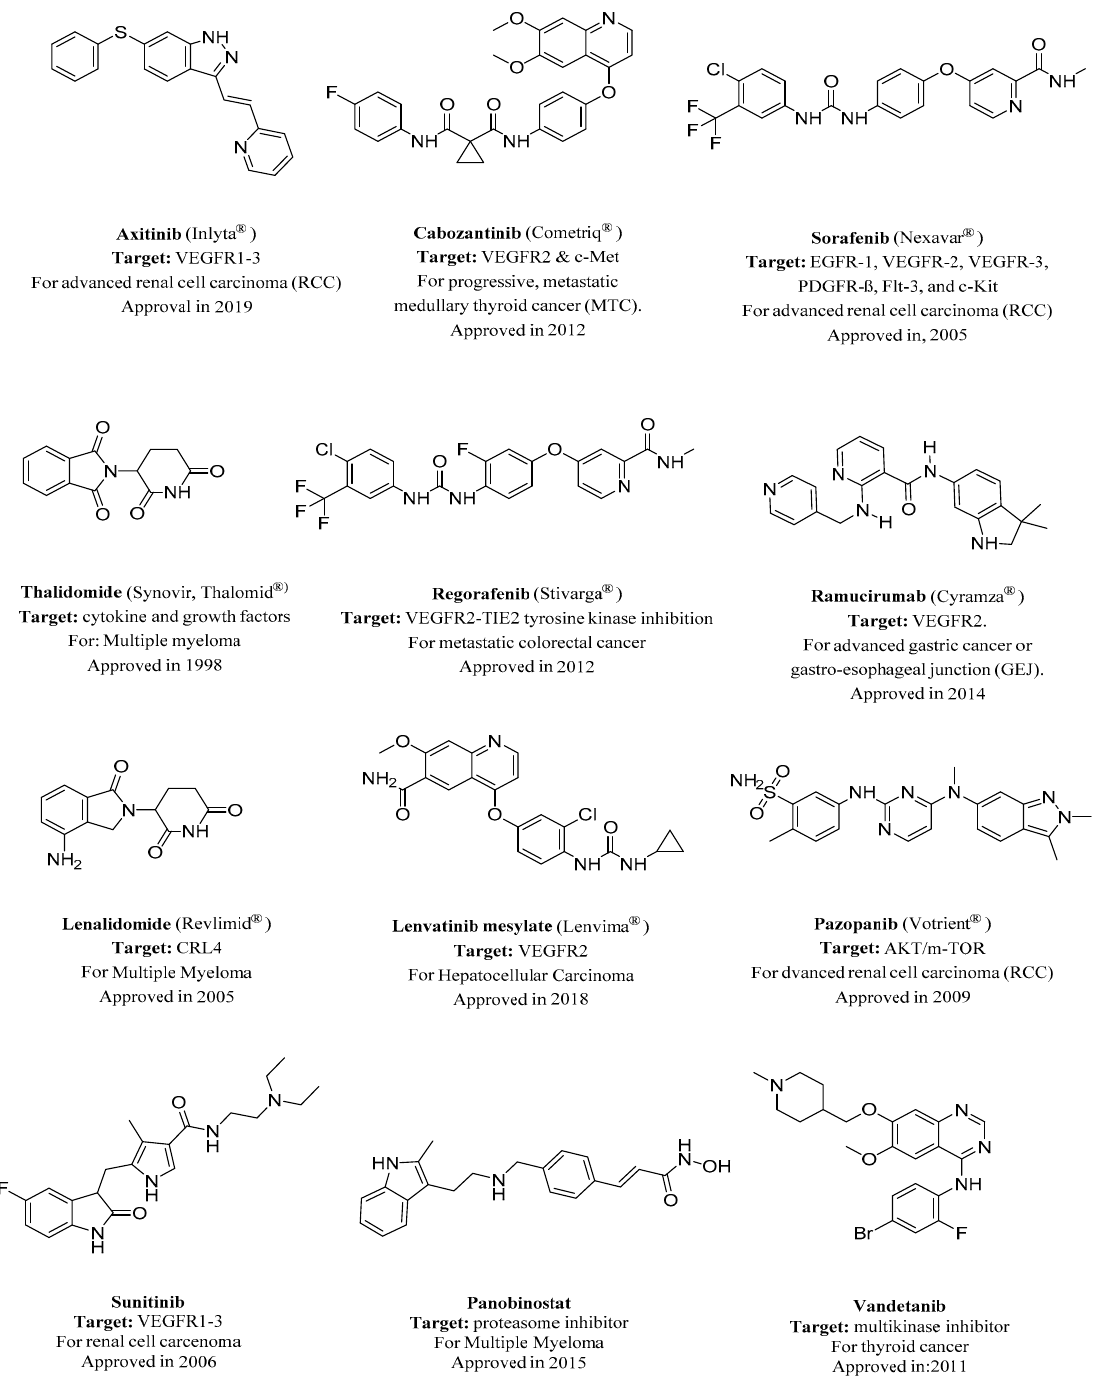
Figure 1. FDA-approved angiogenesis inhibitors for treatment of cancer [18,19]. VEGFR, vascular endothelial growth factor